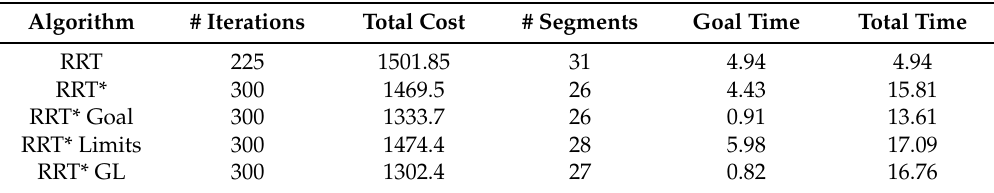
Table 4. Results. One obstacle, 300 iterations a .